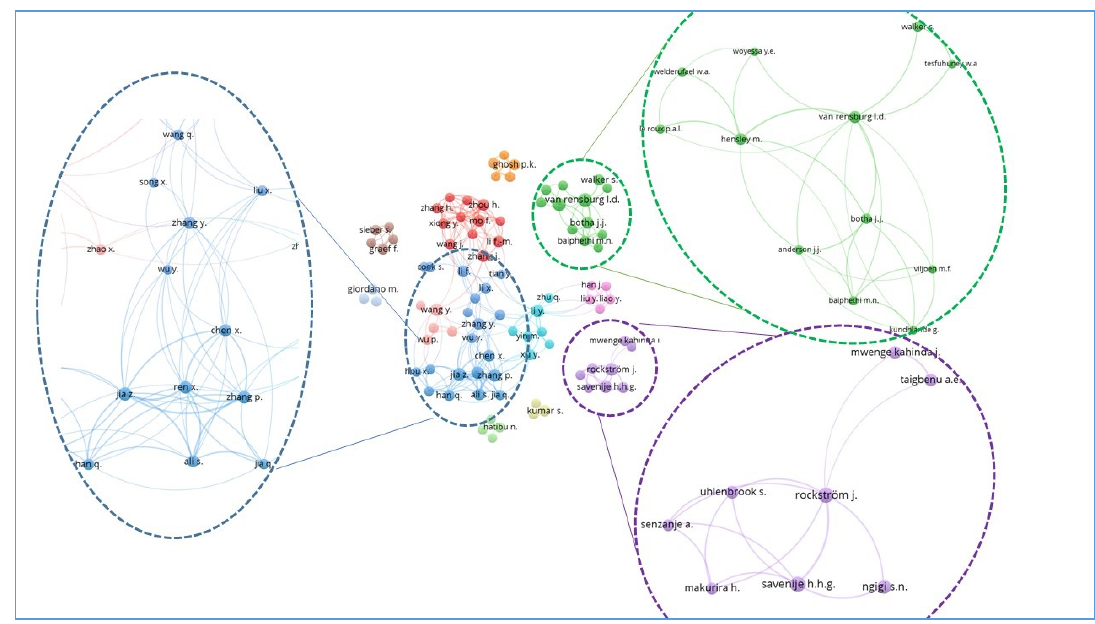
Figure 5. Main relationships between authors in RWHI research.